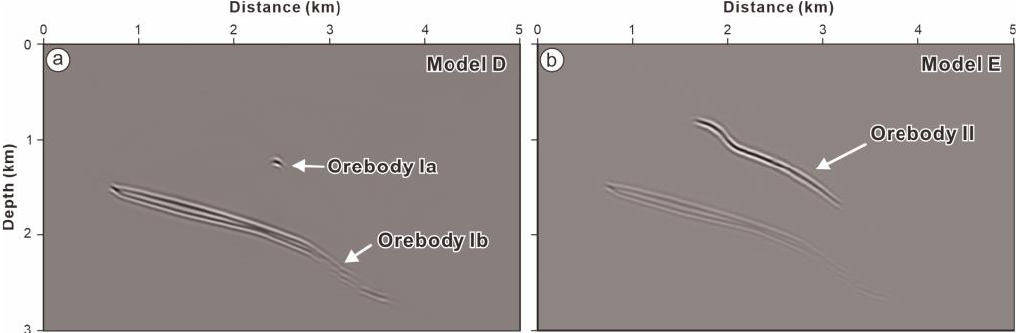
Figure 3. RTM imaging results of models D ( a ), and E ( b ). Minerals 2022 , 12 , x FOR PEER REVIEW